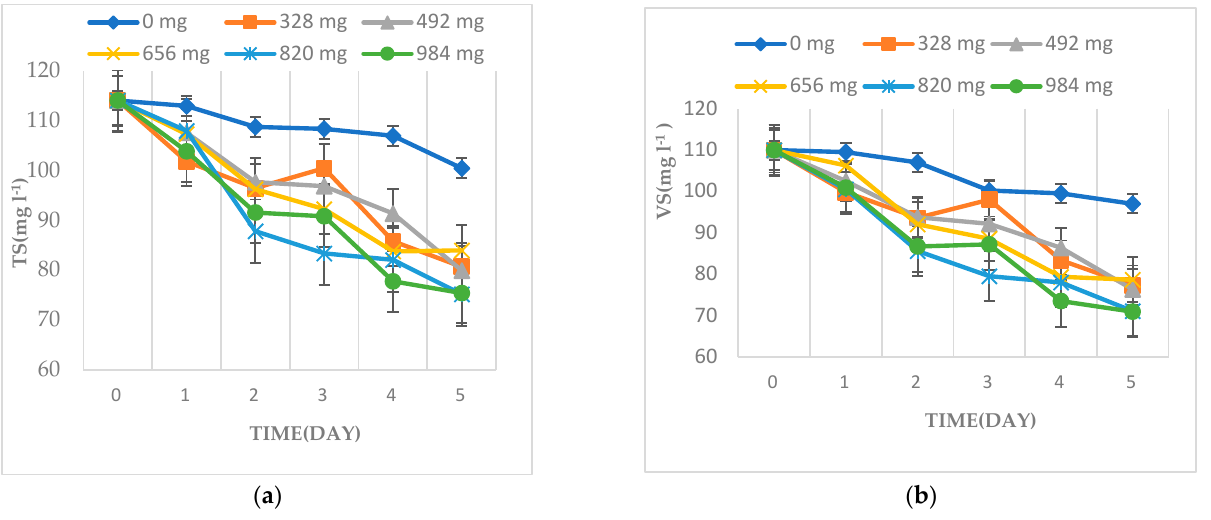
Figure 4. Changes in ( a ) TS and ( b ) VS of food waste hydrolysis with different amounts of biofilm and time of digestion at T = 35 ± 2 °C.